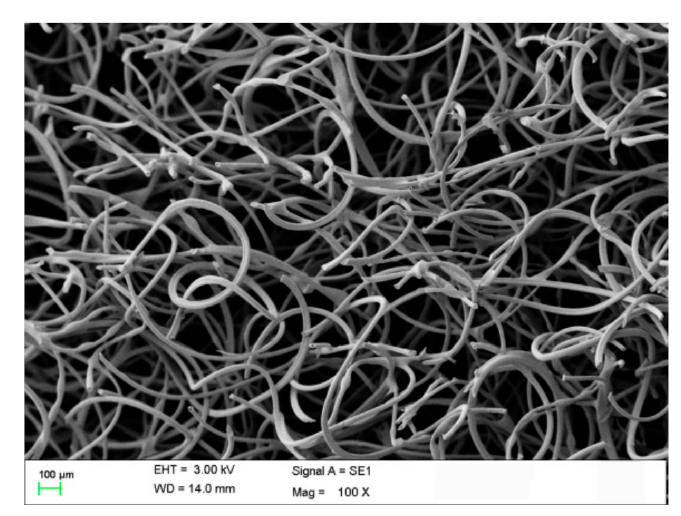
Figure 3. SEM images of typical PLON